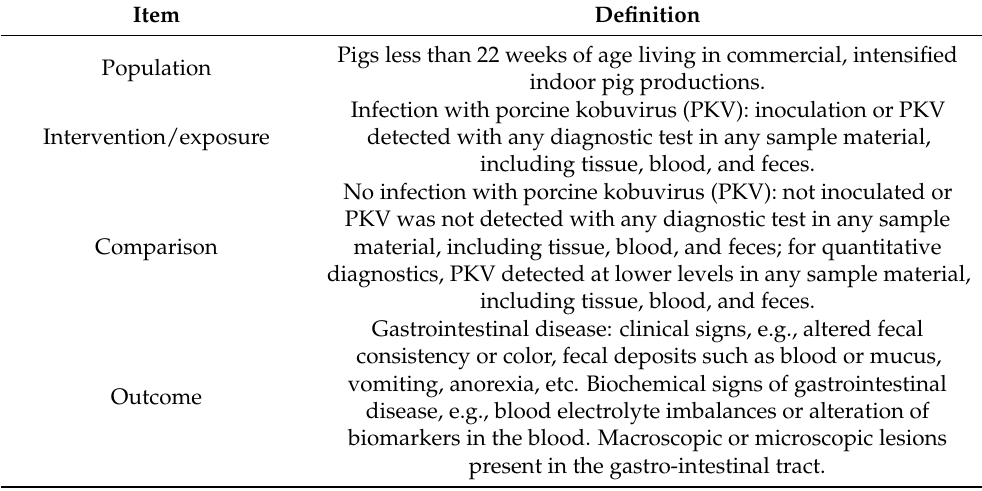
Table 1. Specification of the four items defining the clinical question answered in this